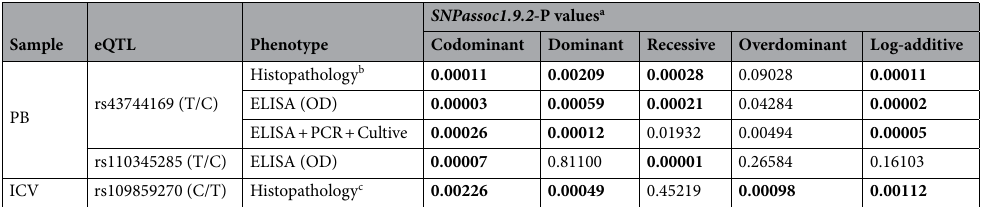
Table 3. Associations between the rs43744169, rs110345285, rs109859270, and PTB diagnostic results. a Statistically significant P-values after Bonferroni correction are shown in bold. b PTB-associated histopathological lesion were classified as focal, multifocal, diffuse paucibacillary, diffuse intermediate, diffuse multibacillary. c Presence or absence of PTB-histopathological lesions.